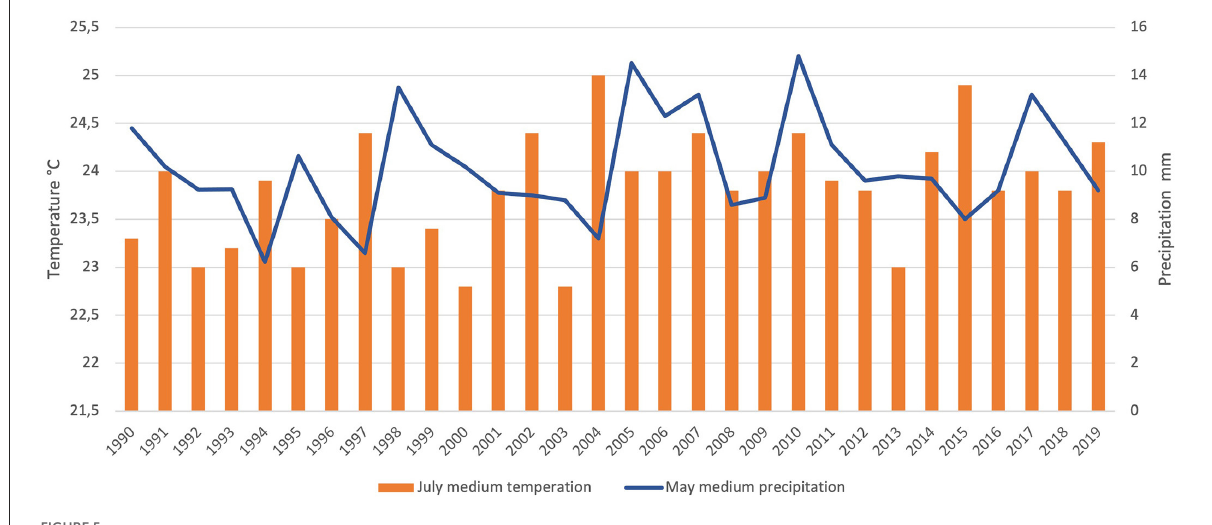
FIGURE5 Average monthly precipitation and temperature for May and July since 1990 in the study area. The orange bars show the average monthly temperature for the month of July and the blue line the average monthly precipitation for May during the last 29 years.